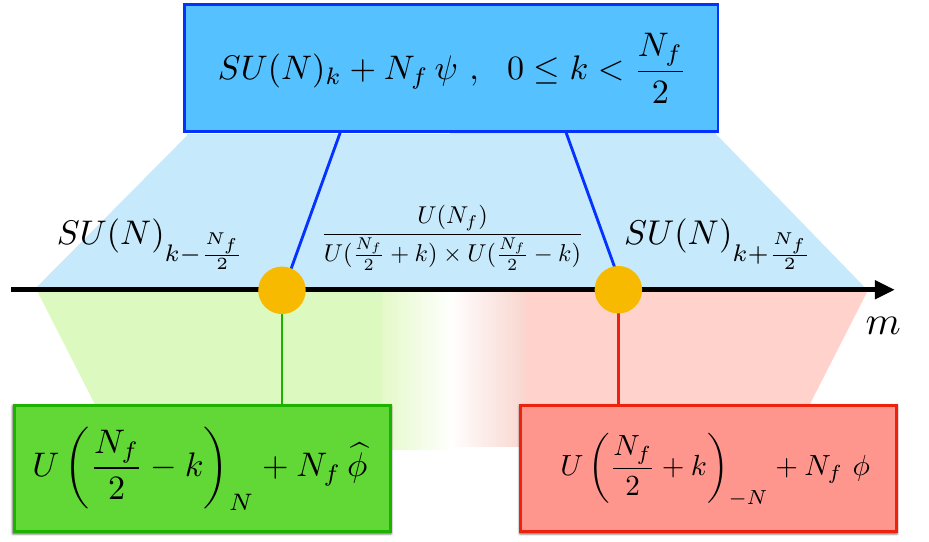
N f (shown in blue). In addition 3 with 0 (cid:20) k < 2